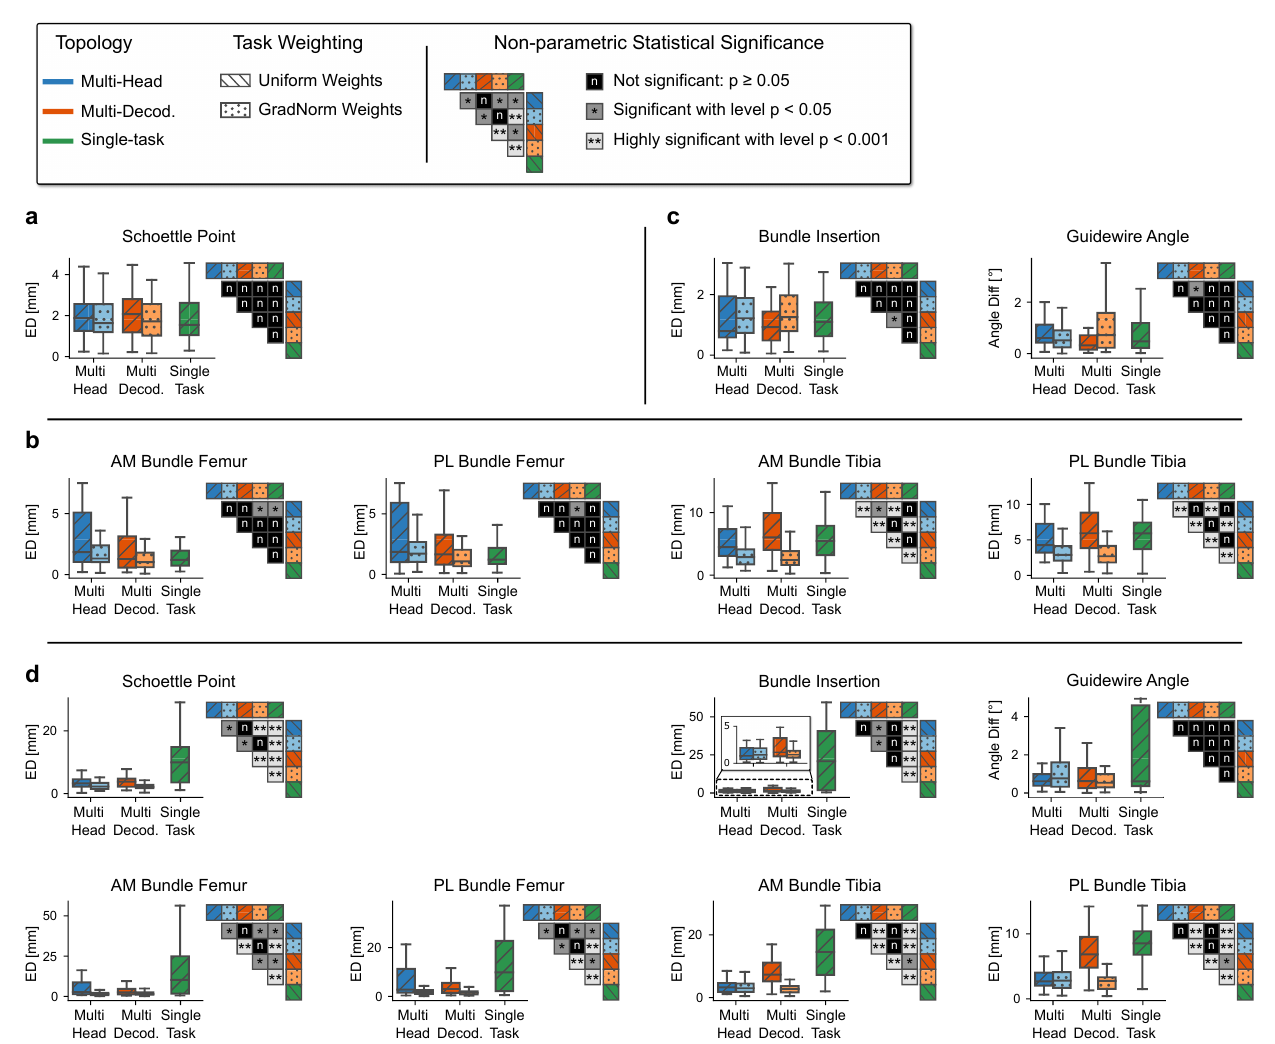
Figure 6. Boxplots of the planning metrics for each surgical application and different model topologies and optimization policies (without fliers/outliers). ( a ), MPFL. ( b ), ACL. ( c ), PCL. ( d ), combined (MPFL, ACL, and PCL). For each boxplot and topology pairing, we tested statistical significance with a two-sided Mann–Whitney U rank test ((n) not significant: p ≥ 0.05, (*) significant: p < 0.05, (**) highly significant: p <